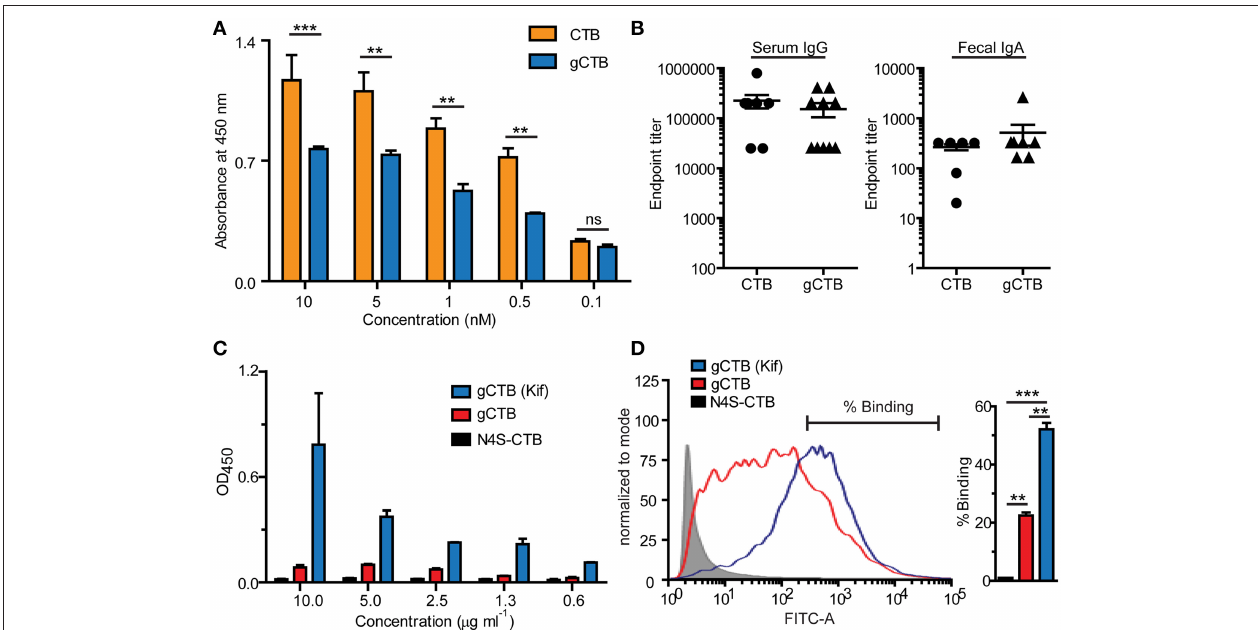
FIGURE 2 | Immune-related effects of N -glycans attached to CTB. The potential impacts of Asn4-glycans on humoral immunity (A, B) and dendritic cell-specific intracellular adhesion molecule 3-grabbing non-integrin (DC-SIGN) binding (C, D) are shown. (A) Reactivity of a commercial polyclonal anti-CTB antibody product (List Biological Laboratories) to native CTB (Sigma-Aldrich) and Asn4-glycosylated CTB expressed in N. benthamiana (gCTB; no C-terminal KDEL attached). An ELISA plate was coated with GM1-ganglioside, to which varying concentrations of native CTB or gCTB were added. The receptor-bound CTB or gCTB were detected by incubation with the polyclonal antibodies followed by anti-goat IgG secondary antibodies, as described previously (Hamorsky et al., 2015). Native CTB and gCTB have a comparable affinity to GM1-ganglioside (Hamorsky et al., 2015). The anti-CTB antibodies recognized native CTB significantly better than gCTB, suggesting antigenic masking or a “glycan shield” effect by Asn4 glycans. ** P < 0.01 ; *** P < 0.001 ; Two-way repeated measures analysis of variance (ANOVA) with Bonferroni’s posttest (GraphPad Prism 5). (B) Serum and Fecal anti-cholera holotoxin antibody titers of C57bl/6 mice orally immunized with native CTB or gCTB (3 µ g per mouse, twice at a 2-week interval; graphs adapted from Hamorsky et al., 2015, under the Creative Commons Attribution License). (C) DC-SIGN-binding activity of gCTB and an aglycosylated plant-made CTB (N4S-CTB). An ELISA plate was coated with varying concentrations of gCTB, gCTB produced in plants treated with kifunensin (Kif) or N4S-CTB, to which a human DC-SIGN-Fc fusion (Sino Biological) was added. The bound DC-SIGN was detected with an anti-human IgG Fc secondary antibody. (D) gCTB’s binding to cell-surface DC-SIGN. Raji cells expressing DC-SIGN were incubated with Alexa Fluor ® 488-labeled N4S-CTB-KDEL, gCTB, or gCTB (Kif) at a final concentration of 10 µ g/ml, and analyzed by flow cytometry. ** P < 0.01 , *** P < 0.001 ; One-way ANOVA with Bonferroni’s multiple comparison test (GraphPad Prism 5). Graphs adapted from Hamorsky et al. (2015), under the Creative Commons Attribution License.